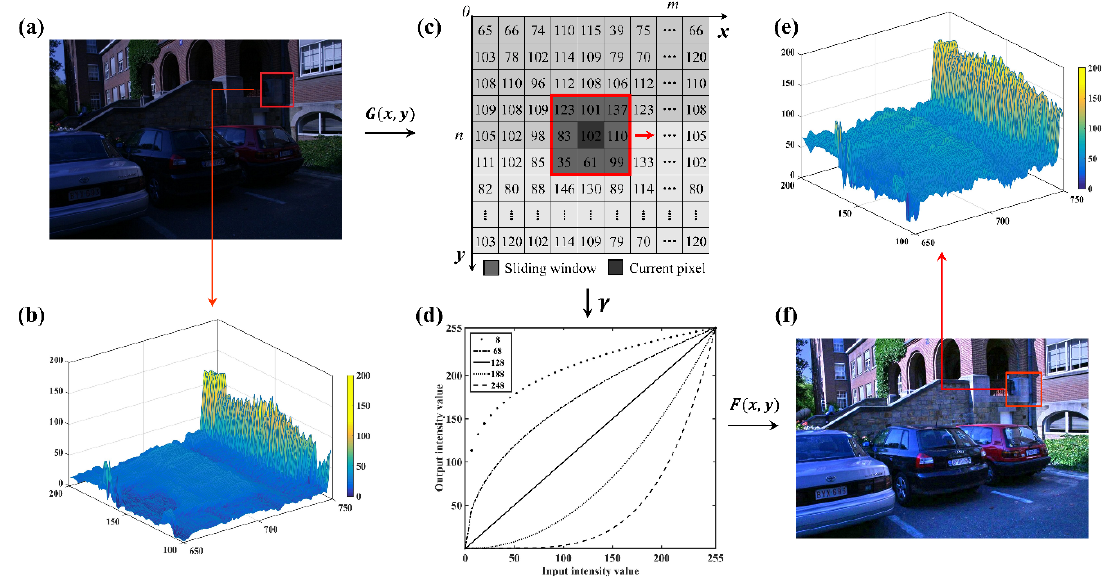
Figure 2. Adaptive luminance equalization: ( a ) original image G ( x , y ); ( b ) the luminance distribution of a local region for original image (red rectangle in ( a )); ( c ) the adaptive equalizing scheme based on illumination map; ( d ) adaptive luminance equalization model; ( e ) the luminance distribution of a local region for the transformed image (red rectangle in ( f )); and ( f ) the transformed image F ( x , y ).